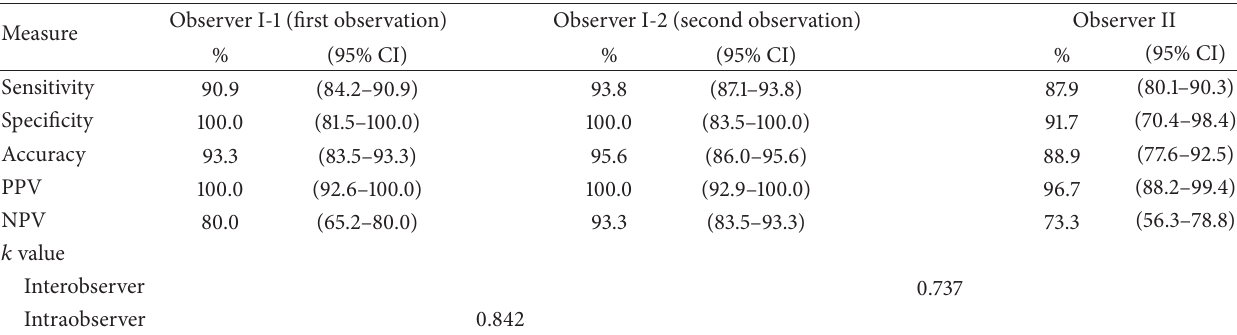
Table 5: The sensitivity, specificity, accuracy, PPV, NPV, and intra- and interobserver agreement using the “limited-to-four-pattern sign” observed on NBI-ME for the differential diagnosis between S-LG-tub1 and